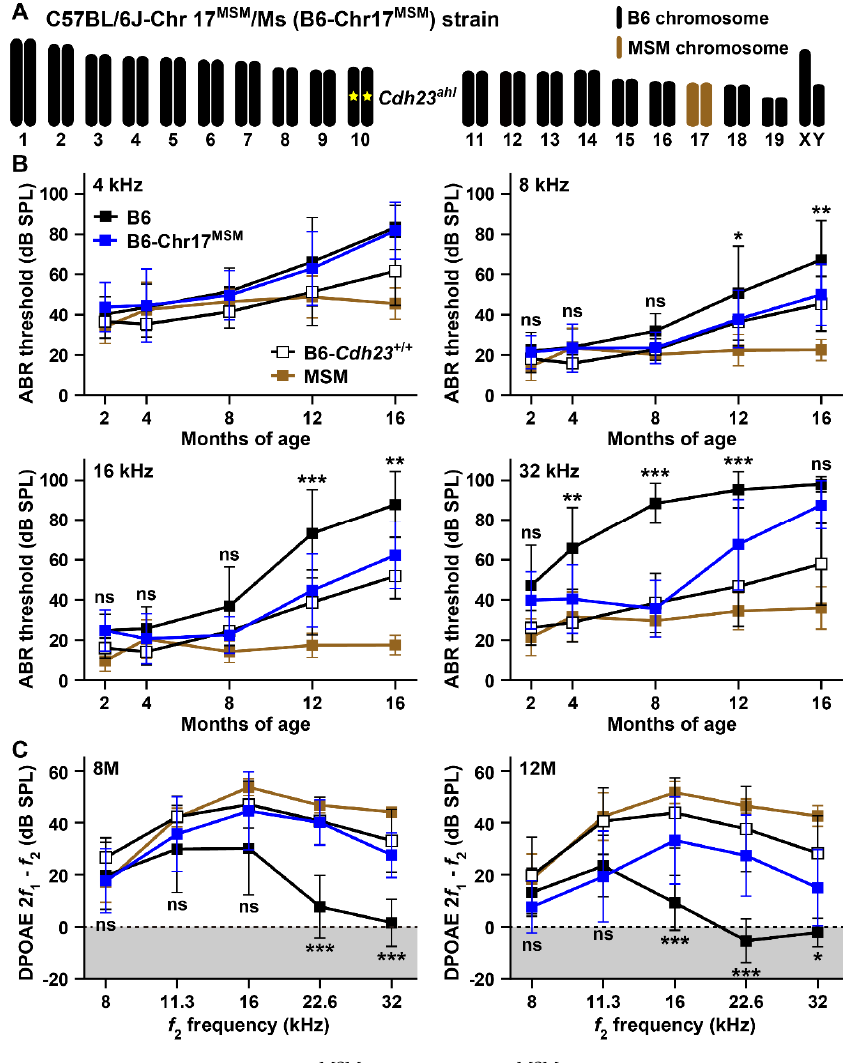
Figure 6. The C57BL/6J-Chr 17 MSM /Ms (B6-Chr17 MSM ) consomic strain exhibits delayed ARHL onset: ( A ) Schematic chromosomal structure of a B6-Chr17 MSM strain. A yellow star on chromosome 10 indicates Cdh23 ahl allele. ( B ) Comparison of the ABR thresholds at 4, 8, 16, and 32 kHz sound stimuli among male mice of the B6, MSM, B6- Cdh23 +/+ , and B6-Chr17 MSM strains at 2 (B6, n = 15; MSM, n = 12; B6- Cdh23 +/+ , n = 12; B6-Chr17 MSM , n = 16), 4 (B6, n = 15; MSM, n = 15; B6- Cdh23 +/+ , n = 12; B6-Chr17 MSM , n = 15), 8 (B6, n = 14; MSM, n = 11; B6- Cdh23 +/+ , n = 12; B6-Chr17 MSM , n = 16), 12 (B6, n = 15; MSM, n = 14; B6- Cdh23 +/+ , n = 12; B6-Chr17 MSM , n = 18), and 16 (B6, n = 12; MSM, n = 11; B6- Cdh23 +/+ , n = 10; B6-Chr17 MSM , n = 12) months of age. ( C ) Comparison of DPOAE (2 f 1 - f 2 ) amplitudes against the f 2 frequencies at 8, 11.3, 16, 22.6, and 32 kHz among male mice of the B6, MSM, B6- Cdh23 +/+ , and B6-Chr17 MSM strains at 8 (B6, n = 14; MSM, n = 12; B6- Cdh23 +/+ , n = 13; B6-Chr17 MSM , n = 11) and 12 (B6, n = 15; MSM, n = 12; B6- Cdh23 +/+ , n = 12; B6-Chr17 MSM , n = 12) months of age. The means (squares) and SDs (error bars) of the ABR thresholds and DPOAE amplitudes are shown. Two-way ANOVA revealed significant strain effects between B6 and B6-Chr17 MSM strains of the ABR thresholds at 8, 16, and 32 kHz and the DPOAE amplitudes at 8 and 12 months of age (Tables S7 and S8). The asterisks and “ns” symbols indicate significant (* p < 0.05, ** p < 0.01, and *** p < 0.001) and no significant differences, respectively, between B6 and B6-Chr17 MSM strains at the same age of the ABR thresholds and at the same frequency of the DPOAE amplitudes, determined using Sidak’s (8 kHz in B) and Tukey’s (16 and 32 kHz in ( B , C )) multiple comparison tests after two-way ANOVA. The noise floors (gray zones) are adjusted to 0 dB SPL in ( C